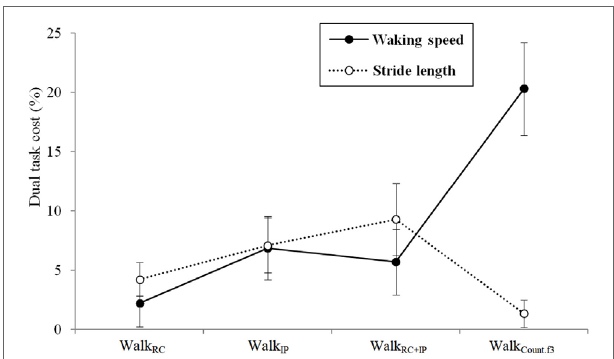
FigUre 2 | Dual task costs in walking speed and stride length depending on the